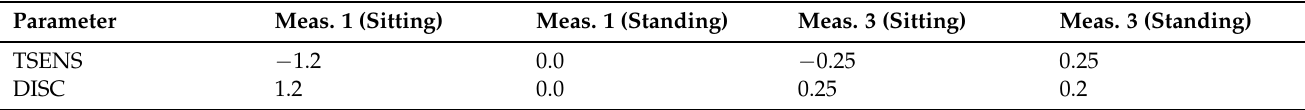
Table 10. End values of TSENS and DISC for Meas. 1 and Meas. 3 and both sitting and standing test subjects. Parameter